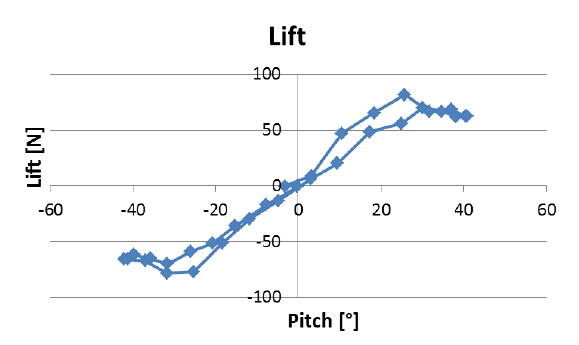
Fig. 10. Lift force divided for upper and lower sides, Ma =